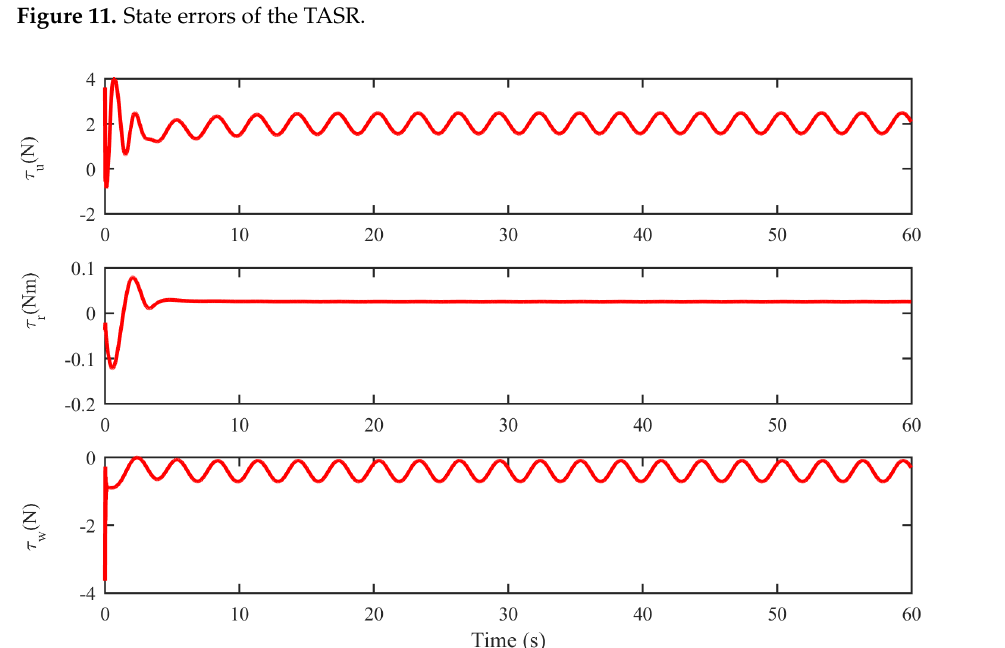
Figure 11. State errors of the TASR.